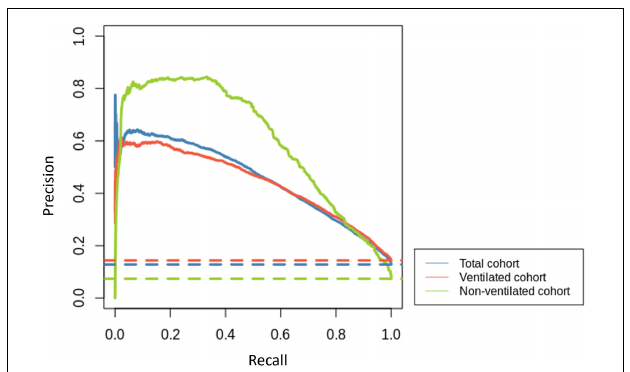
FIGURE 2 | Precision-recall curves for the total cohort (blue), ventilated cohort (red) and non-ventilated cohort (green) are represented with solid lines. Their corresponding baselines are represented with dashed lines.